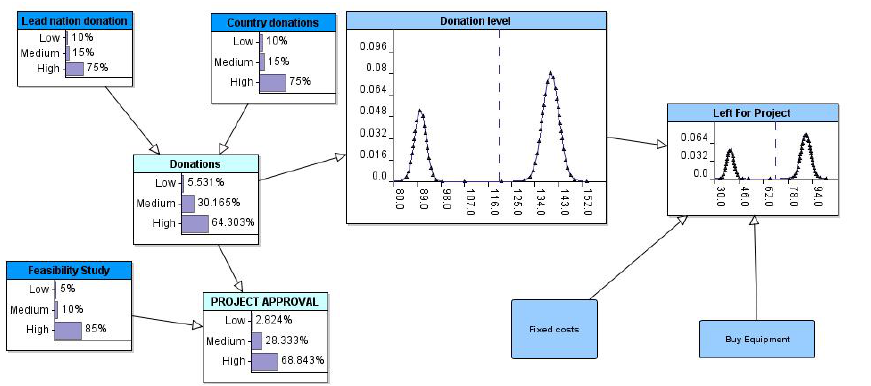
Figure 3 – Risk Map model with the initial probabilities for the NTF Policy Рис . 3 – Карта рисков с инициальной